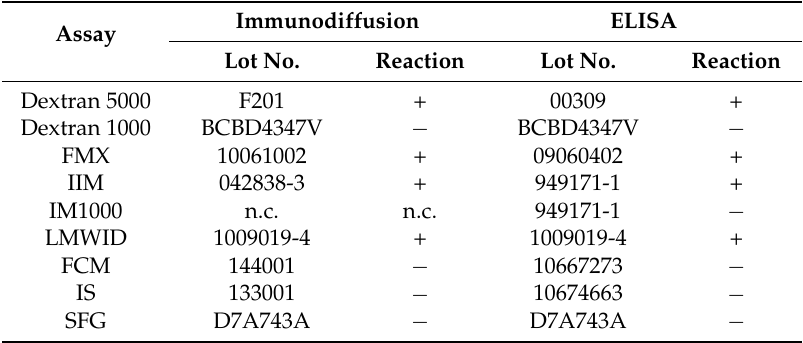
Table 3. Reactivity of IV iron preparations and isomaltoside 1000 with 5E7H3 by reverse single radial immunodiffusion and ELISA.